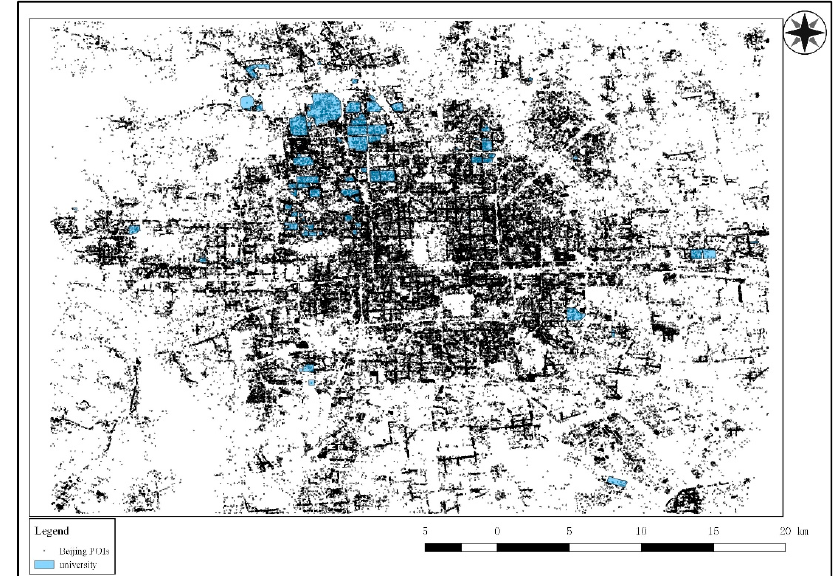
Figure 8. ROI validation set. The figure shows the distribution of the ROIs labeled “university”, represented by the blue regions in the research region. These were utilized to verify the effectiveness of the keyword query for the ROI of the corresponding label.